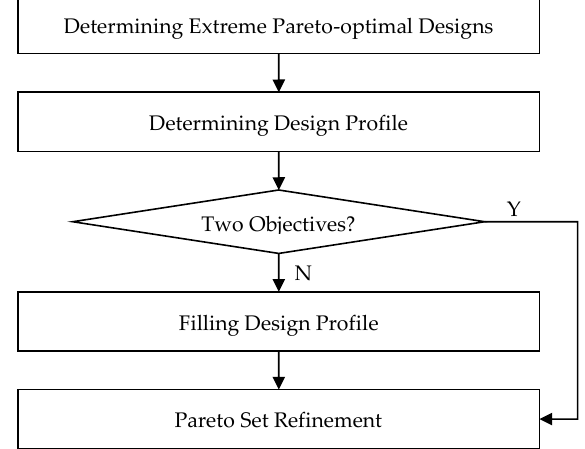
Figure 1. Algorithm flowchart of generalized sequential domain patching (GSDP).